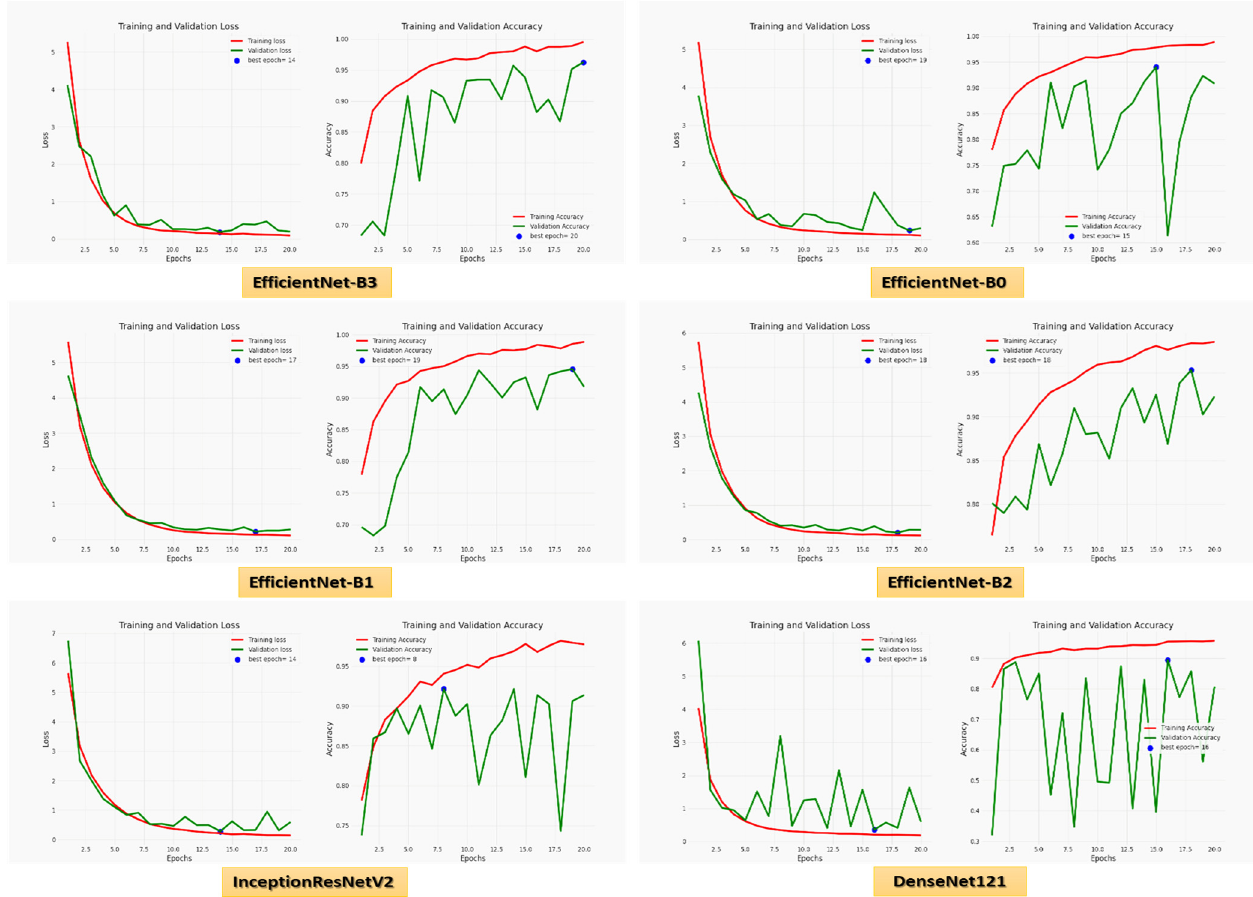
Figure 6. The loss and accuracy curves for the six CNN models using a fixed LR.